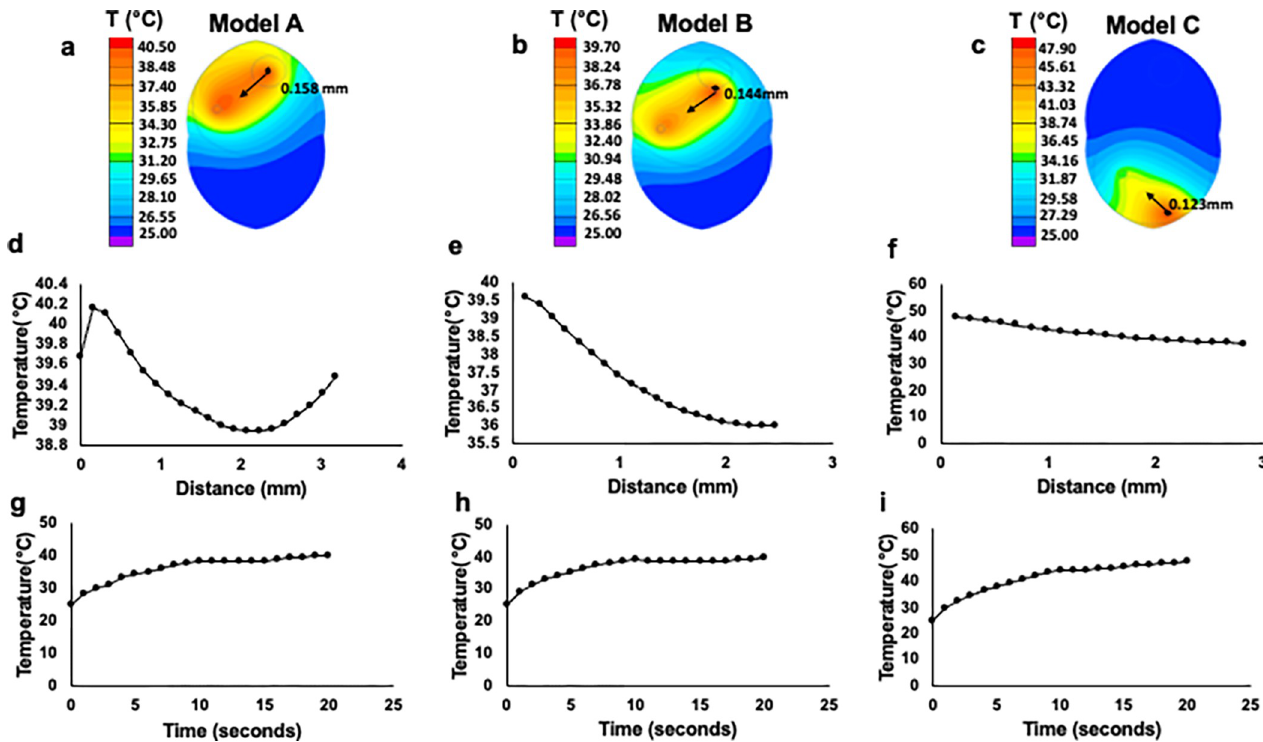
Fig 4. Joule heating of the brain tissue during the application of pulsed electric fields for e-biopsy. Simulations results for the three scenarios are shown: e- biopsy needle in the center of the tumor (Center, Model A), e-biopsy needle at the distance of 0.5mm from the visible tumor margin (Margin, Model B), and e- biopsy needle at the distance of 10mm (Healthy brain, Model C). Panels a-c show the simulation for high voltage, short-duration protocol: 40 pulses 1000 V, 40 μ s, 4 Hz, coupled with the simulation for low voltage, long-duration protocol: 40 pulses 50 V, 15 ms, delivered at 4 Hz. The simulations assume electric tissue conductivities of fully electroporated tissues: brain conductivity 0.882 S m -1 , melanoma conductivity 1.47 S m -1 [53]. Arrows show the contour temperature, numbers show the location of the point beneath the electrode, temperature changes in time. Panels d-f show temperature change as a function of distance from e-biopsy harvesting electrode over contours in panels a-c . Panels g-i show temperature change as a function of time at a point located at 0.158mm distance from the e-biopsy harvesting electrode in Model A, 0.144mm in Model B, and 0.123mm in Model C. Simulations results as presented in panels d-f give rise to the high temperatures at points that are relatively very close to the electrode, as the distance from the electrode increase the temperature decrease.